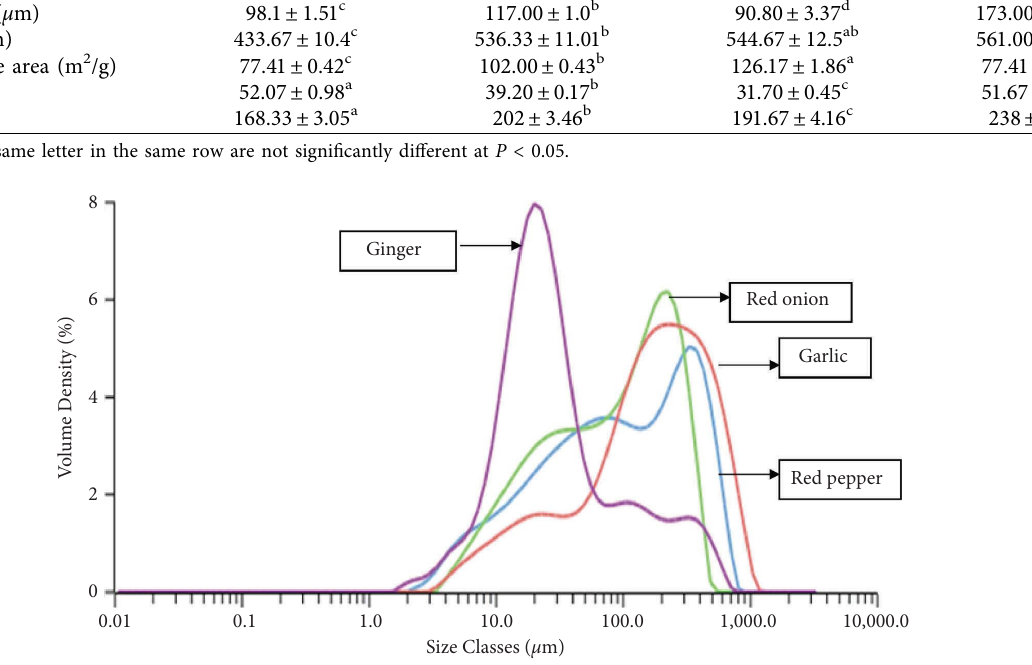
Figure 6: Te particle size distribution of red pepper, red onion, ginger, and garlic. Table 5: Te pasting property and texture property of red pepper, red onion, ginger, and